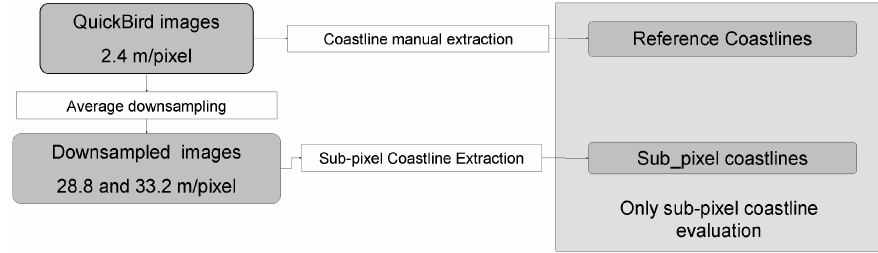
Figure 3. Workflow of the tests performed using downsampled high-resolution (QuickBird)